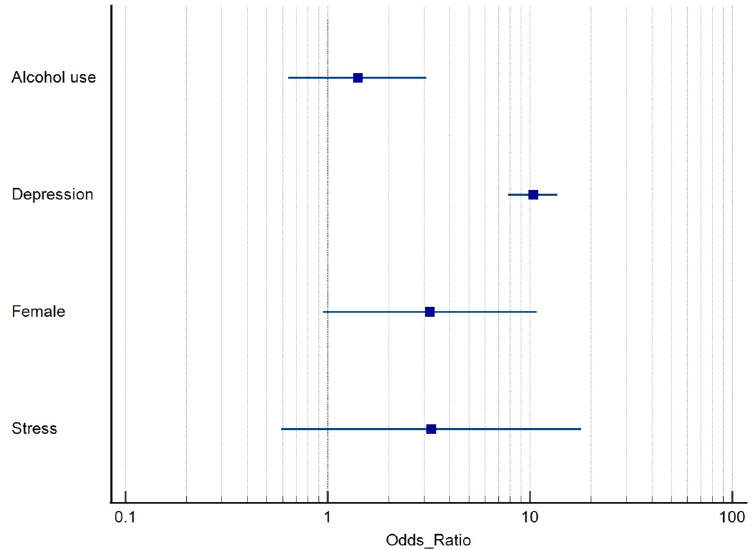
Fig 3. Summary forest plot of pooled effect estimates of risk factors for SA among medical